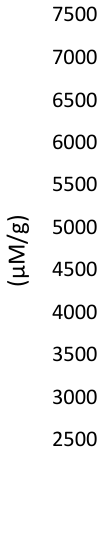
Figure 7. Effect of immersion time on the concentration of free amino acids (FAAs) and ninhydrin- positive substances in the feed. The graph shows mean values ± S.E.